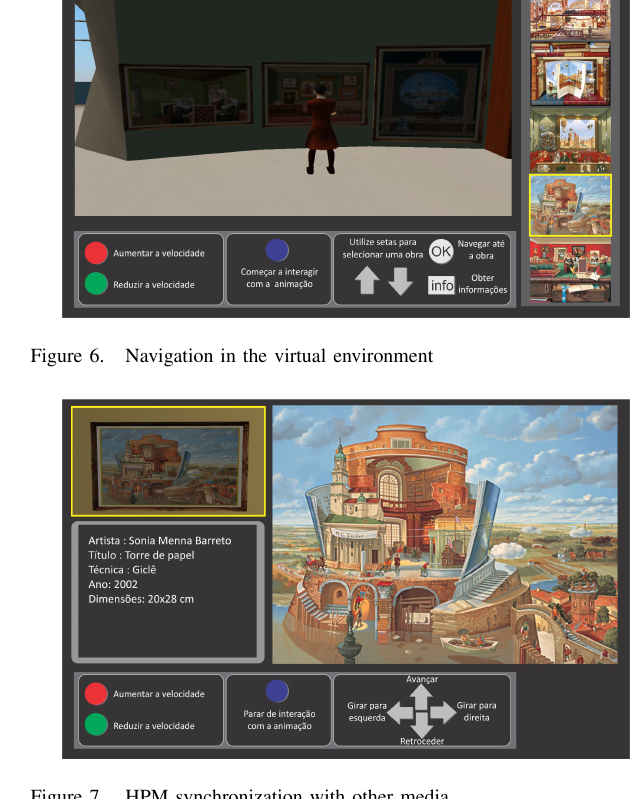
Figure 7. HPM synchronization with other